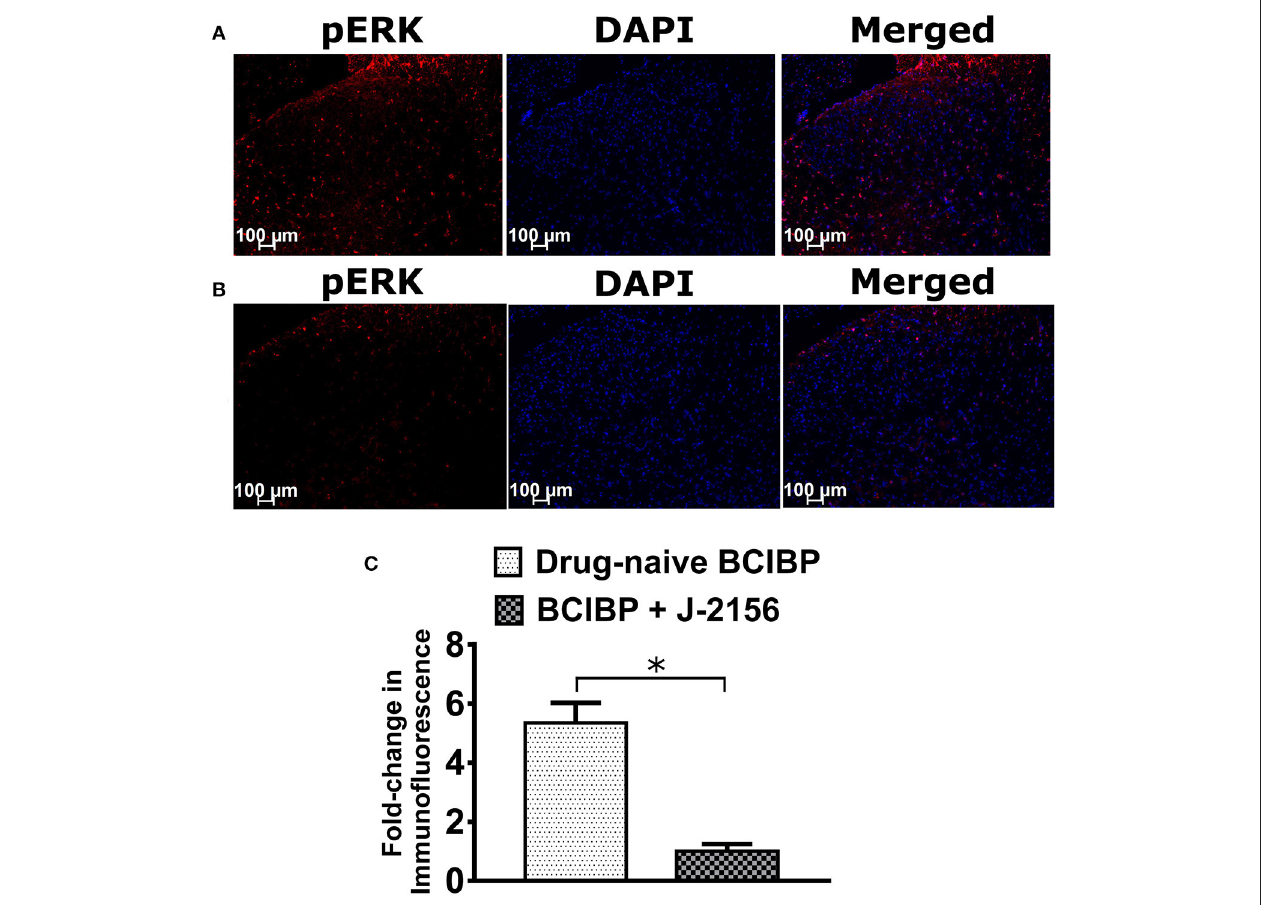
FIGURE 8 | Effect of a single bolus dose of J-2156 (10mg/kg, i.p.) on expression levels of phosphorylated extracellular signal-regulated kinase (pERK) in lumbar L4-L6 spinal dorsal horns of BCIBP-rats ( n = 3–4/group). Panels in the figure show (A) representative section from a drug-naïve BCIBP-rat, (B) representative section from a BCIBP-rat administered J-2156 (10mg/kg, i.p.) and (C) fold-change in immunofluorescence of sections from the BCIBP group administered J-2156 relative to the corresponding sections from the drug-naïve BCIBP group. * p ≤ 0.05 (Mann-Whitney